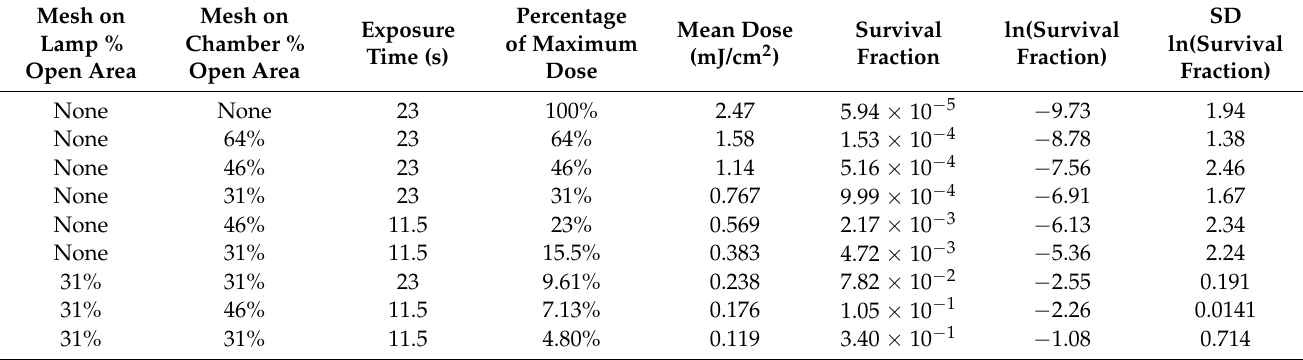
Table 1. Summary of exposure conditions and survival results from the exposure of aerosolized HCoV-OC43 to 222 nm radiation. Combinations of mesh screens, their transmission percentage, and the shielding of half of the exposure window permitted the range of exposure doses used for testing. The mean dose with 100% intensity, achieved with full exposure time and no meshes present, was determined using the computational model. The standard deviation is abbreviated as